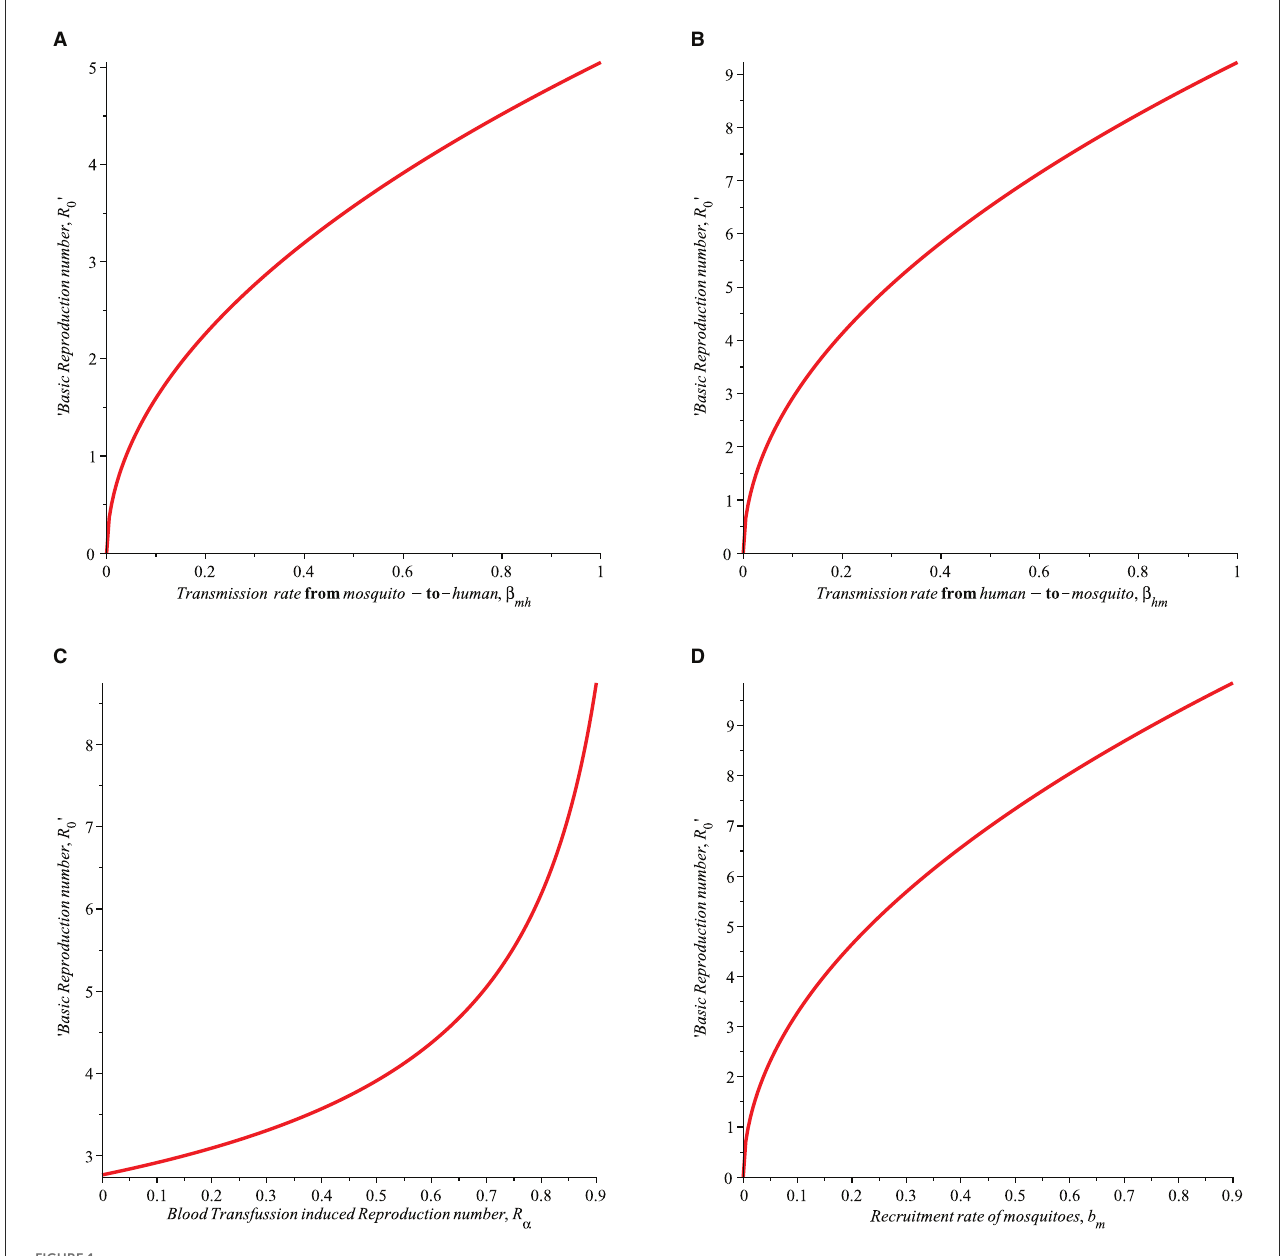
FIGURE1 Simulation showing the impact of (A) transmission rate from mosquito-to-humans ( β mh ), (B) transmission rate from human-to-mosquito ( β hm ), (C) transfusion induced reproduction number ( R α ), and (D) recruitment rate of mosquitoes ( b m ) on the basic Reproduction number ( R 0 ) with parameters set given in Table